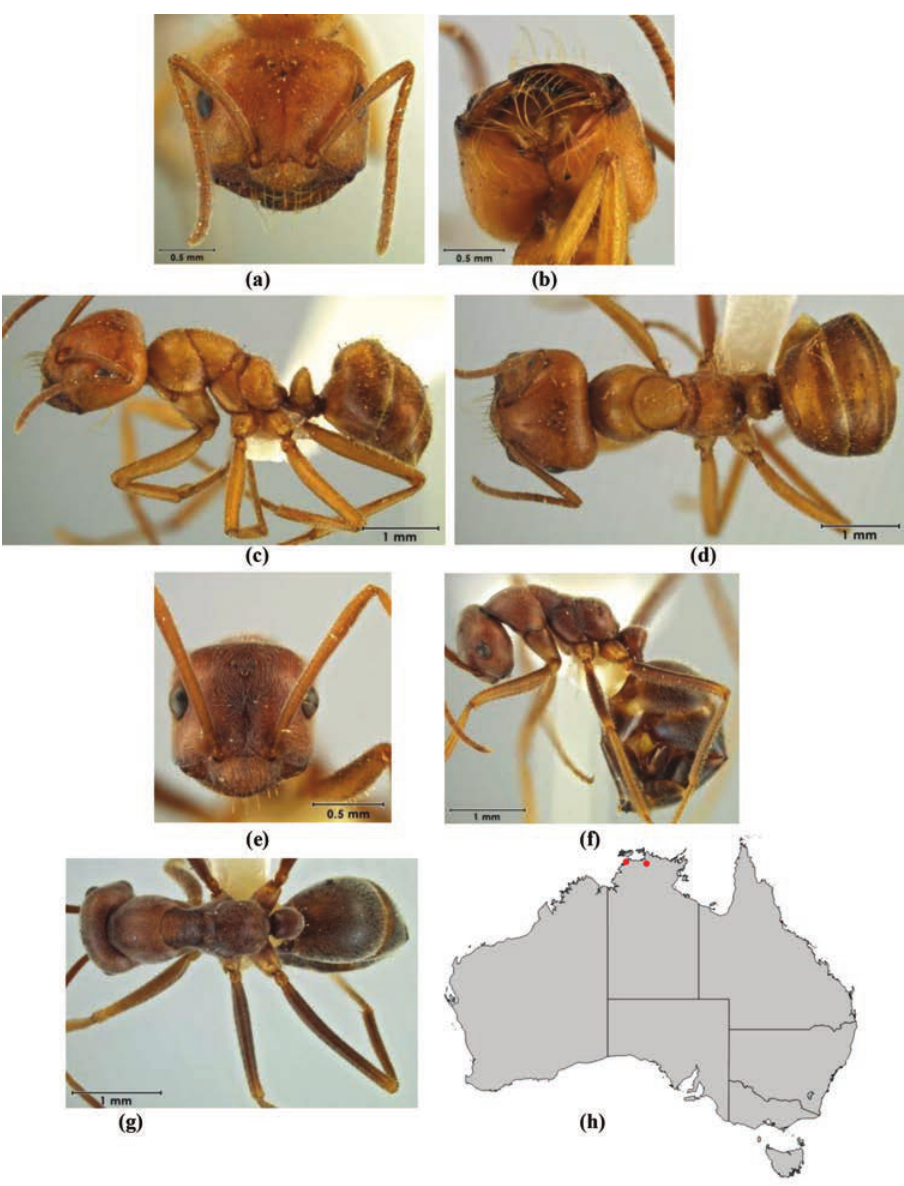
Figure 26. Melophorus anderseni Agosti: non–type major worker (ANIC32-066653) frons ( a ), underside of head showing palps ( b ), profile ( c ) and dorsum ( d ); non–type minor worker (ANIC32-066666) frons ( e ), profile ( f ) and dorsum ( g ); distribution map for the species ( h